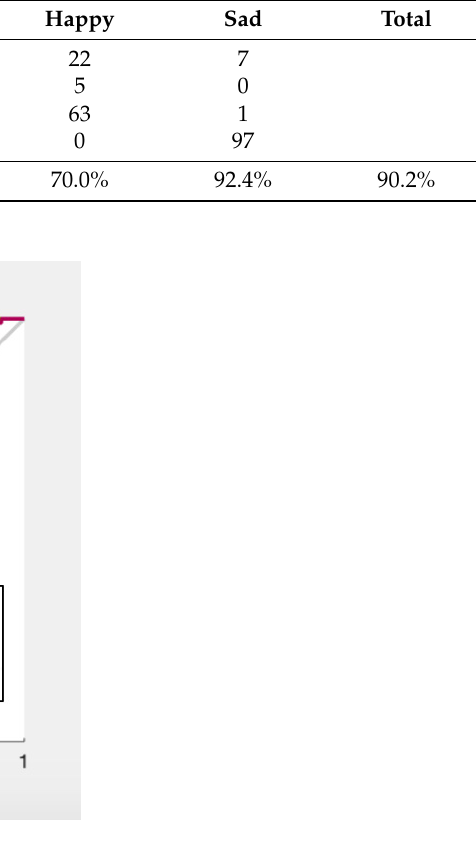
Figure 7. ROCs of all the data sets. Blue: Neutral. Green: Angry. Dark Yellow: Happy. Purple: Sad. Table 1. SER model emotion categorization results on the testing data set (91.3% accuracy).